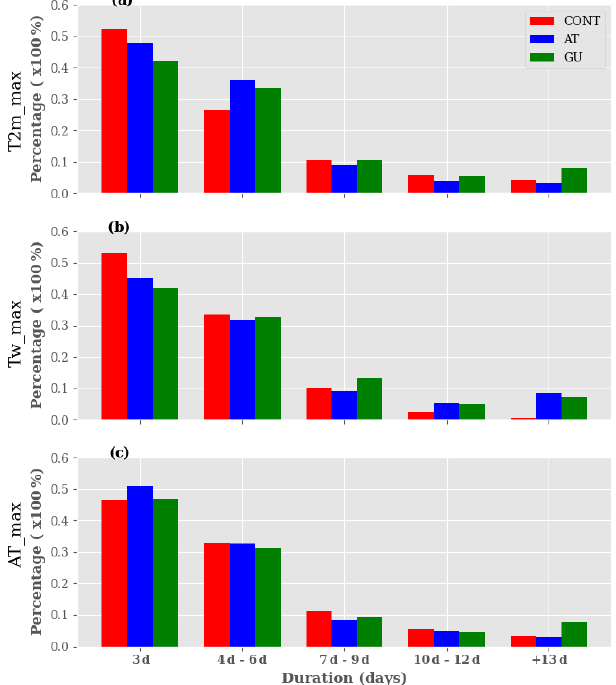
Figure 10. Classification of heat waves using ERA5 reanalysis based on their persistence over the period 1993–2020: (a) T 2m , (b) T w and (c) AT. The detection of heat waves is done using maxi- mum values of the indicators and the climatological daily 90th per- centile. Heat wave detection is firstly carried out, and then their duration is computed. Clusters of heat waves based on their dura- tion (3, 4–6, 7–9, 10–12, 13 + d) are created, and finally, we quan- tify each class of heat waves as a proportion of the total number of events detected. The y and x axes represent the percentage of the heat waves per class and the duration in days respectively. The red/blue/green bars represent the percentage of heat waves detected over CONT/ATL/GU regions (see the “Region of interest” section for more details). The sum of the contribution of heat waves in dif- ferent clusters is equal to 1 for each